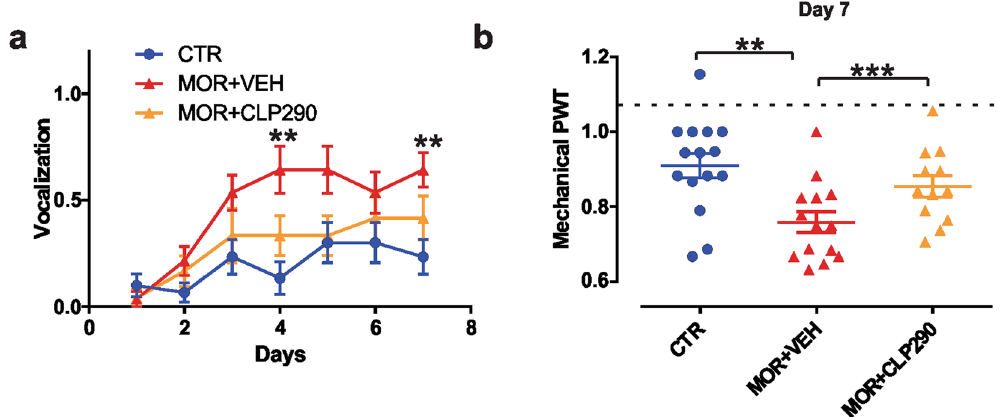
Figure 3. Effect of systemic CLP290 co-treatment on the development of MIH. ( a ) Effect of CLP290 on injection syringe puncture-induced vocalization in CTR (n = 15), MOR + VEH (n = 14) and MOR + CLP290 (n = 12; Kruskall-Wallis test; day 7: P = 0.009; CTR vs . MOR + VEH, ** P < 0.01). ( b ) Effect of CLP290 (100 mg/ kg) on paw withdrawal threshold (PWT) in rats treated with morphine for 7 days. CLP290 (n = 12) or VEH (n = 14) was orally administered every day, twice a day, together with s.c. morphine injection for 7 days; data are compared with saline-treated controls (one-way ANOVA, *** P < 0.001). All PWT values are normalized to the baseline. Abbreviations: CTR = control; VEH = vehicle (20% HP β CD); MOR = morphine; PWT = paw withdrawal